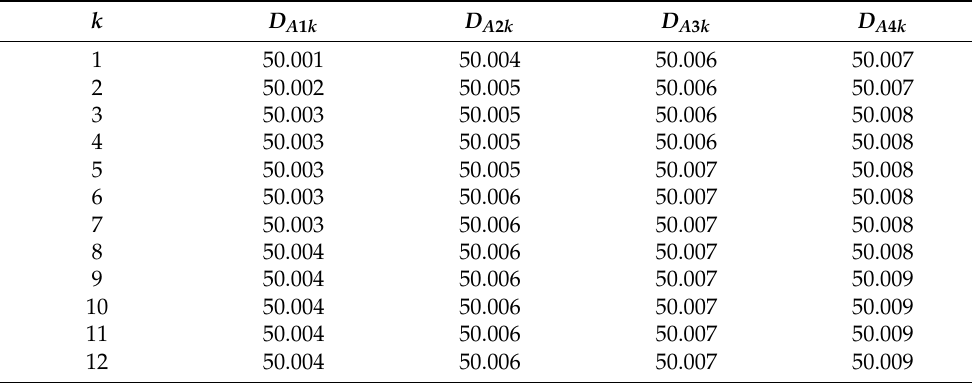
Table 3. Dimensions details of Part A in each bin.